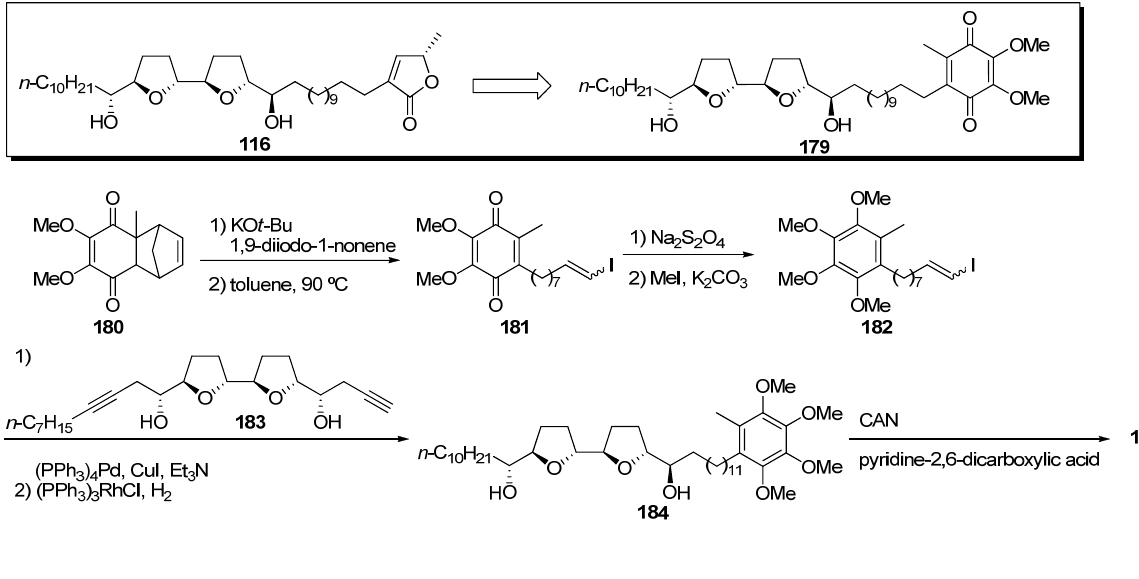
Table 13. Inhibitory potencies of test